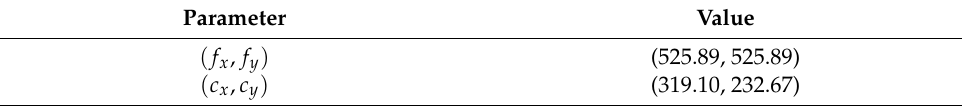
Table 1. Intrinsic parameters of the TOF camera.